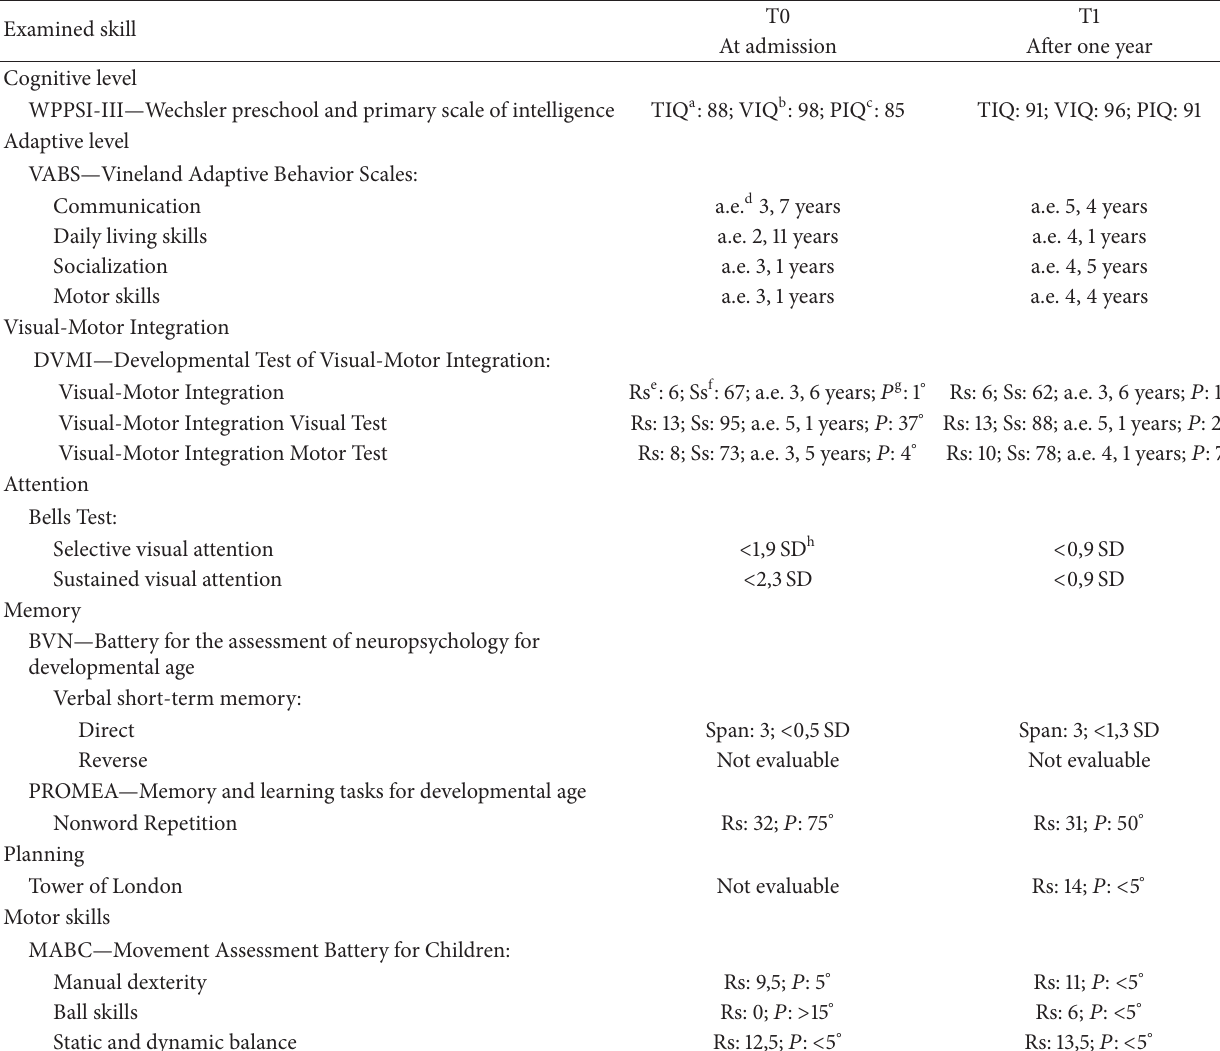
Table 1: Longitudinal cognitive and neuropsychological